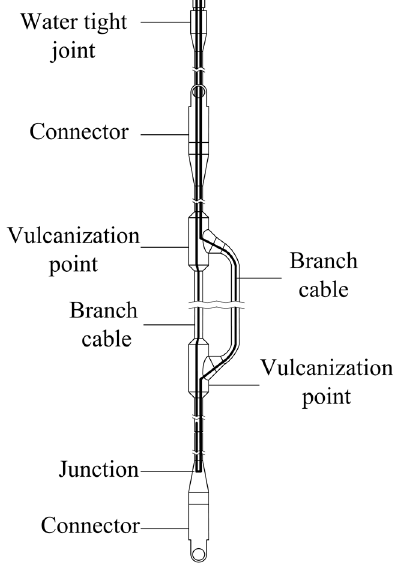
Figure 4. Structure of the mooring cable.